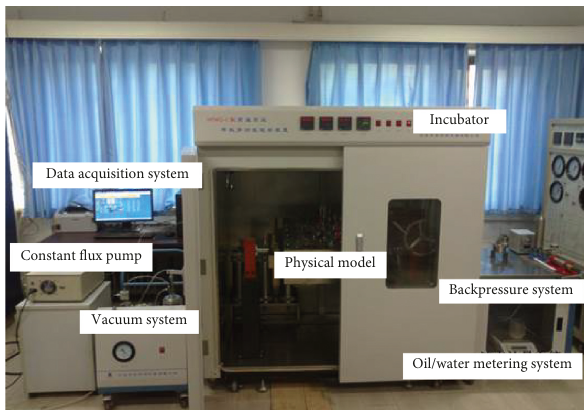
Figure 6: Experiment